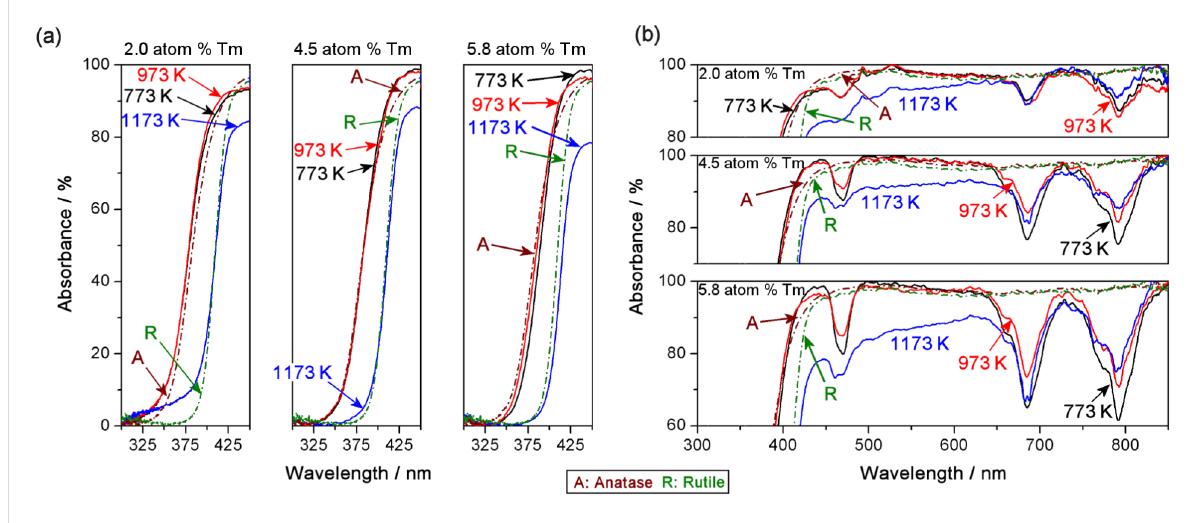
Figure 3: UV–vis spectra of the synthesized samples obtained in diffuse reflectance mode.